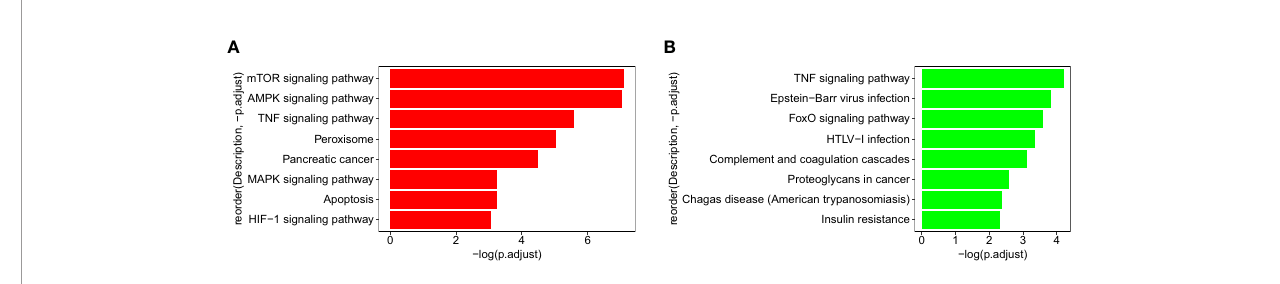
FIGURE 9 | KEGG pathway of blue and thistle2 modules. (A) blue module comprises both the TNF and MAPK signaling pathways. (B) thistle2 module comprises the TNF signaling pathway.